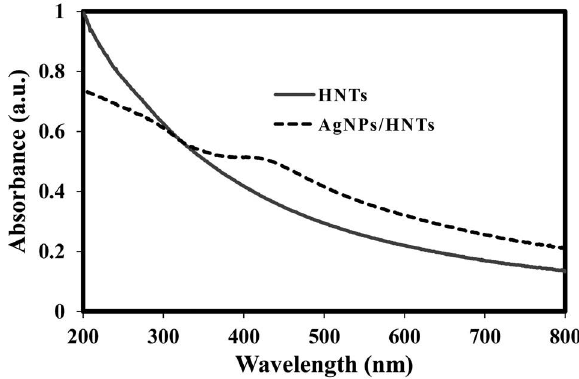
Fig 4. UV–vis spectra of HNTs and Ag/HNTs.